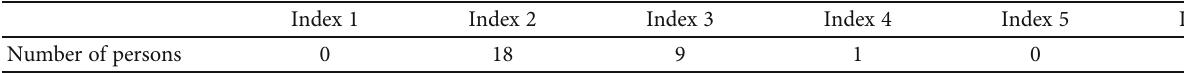
Table 9: The number of opinions that matched the index on the most engaging arcade game.